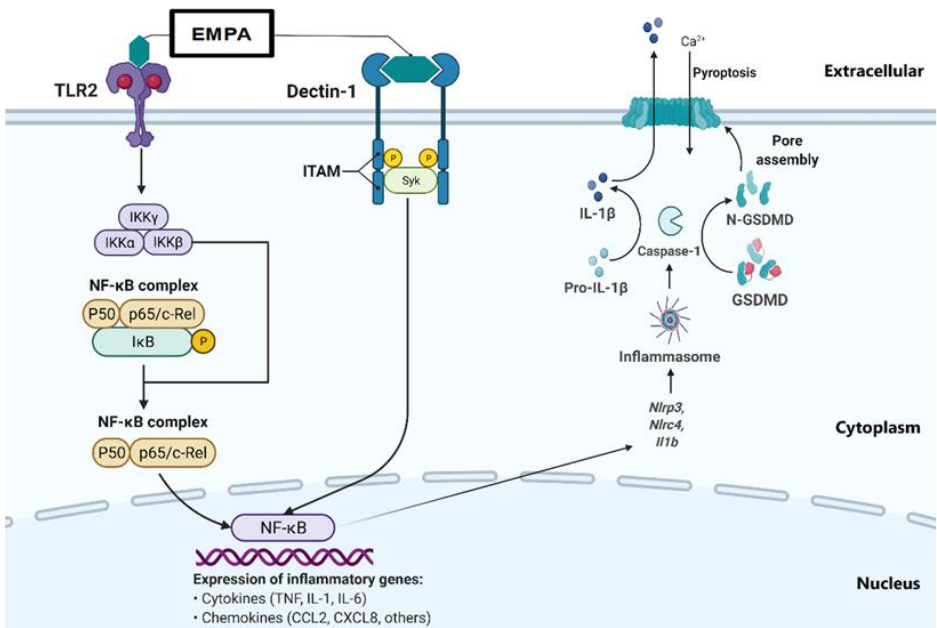
Figure 7. Schematic summarising of the potential interaction of metformin and empagliflozin with TLR2 and Dectin-1 and how they may modulate macrophage inflammatory responses (Empa = empagliflozin, TLR2 = Toll-like receptor-2, Dectin-1 = C-type lectin domain family 7 member A, IKK γ = Inhibitor of nuclear factor kappa-B kinase subunit gamma, IKK α = Inhibitor of nuclear factor kappa-B kinase subunit alpha, IKK β = Inhibitor of nuclear factor kappa-B kinase subunit beta, NF- κ B= Nuclear factor kappa -light-chain-enhancer of activated B cells, ITAM = Immunoreceptor tyro- sine-based activation motif, SYK = Spleen tyrosine kinase, TNF= Tumor necrosis factor, IL-1 = Inter- leukin-1, IL-6 = Interleukin-6, CCL2 = CC chemokine receptor 2, CXCL8 = Chemokine (C-X-C motif) ligand 8, IL- 1β = Interleukin -1 beta, Nlrp3 = NOD-, LRR-, and pyrin domain-containing protein 3, Nlrc4 = NLR Family CARD Domain Containing 4, GSDMD = Gasdermin D, N-GSDMD = N-terminal fragment of GSDMD. Created in BioRender.Com.